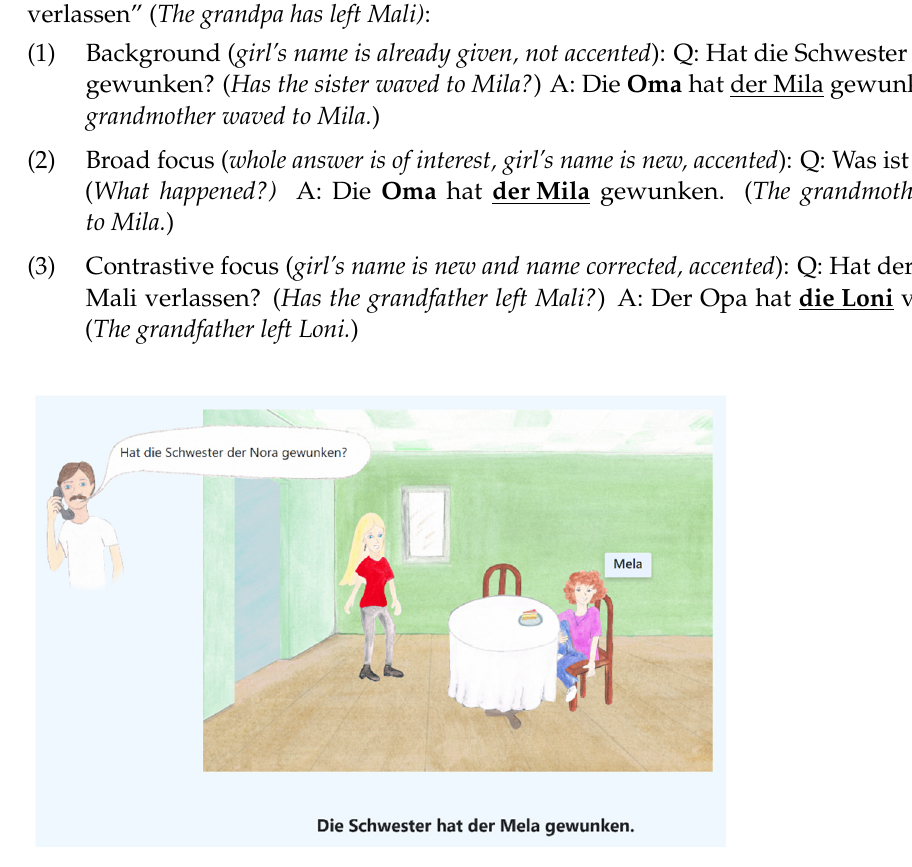
Figure 1. Game-like scenario to elicit target words.